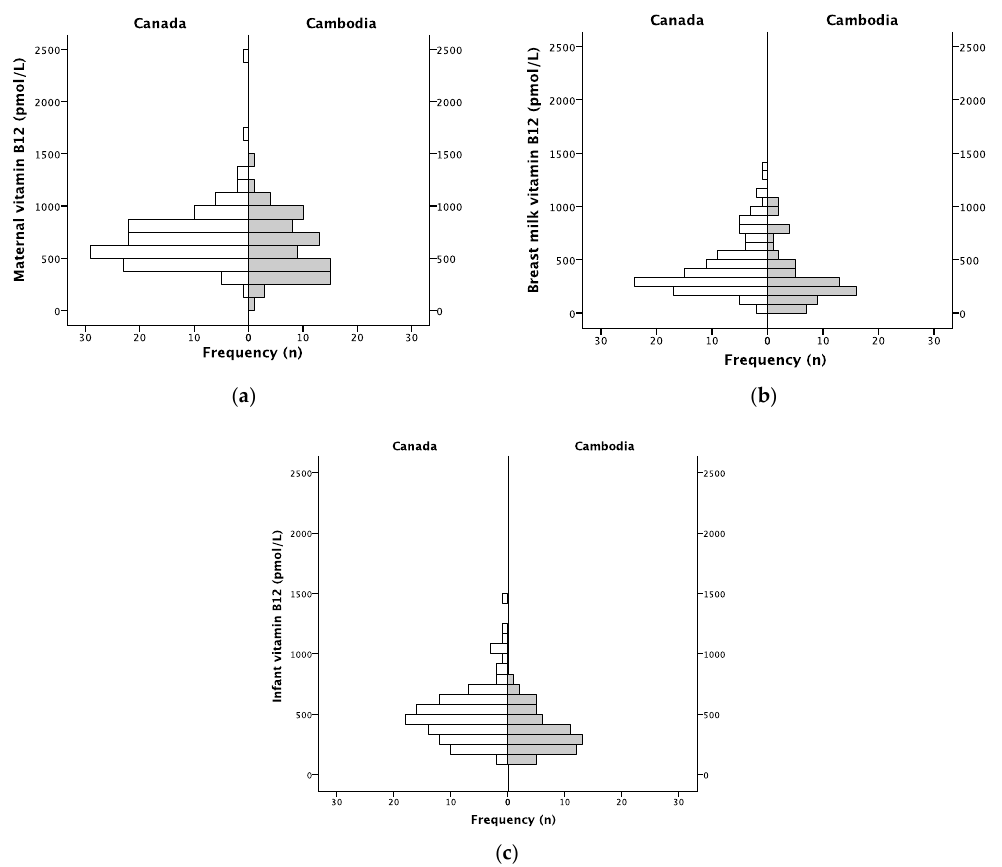
Figure 1. Histograms of ( a ) maternal total vitamin B12 concentrations (pmol/L), ( b ) human milk total vitamin B12 concentrations (pmol/L), and ( c ) infant total vitamin B12 concentrations (pmol/L) among the Canadian (white bars) and Cambodian (shaded bars) samples.